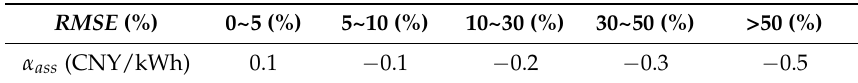
Table 2. Reward-punishment